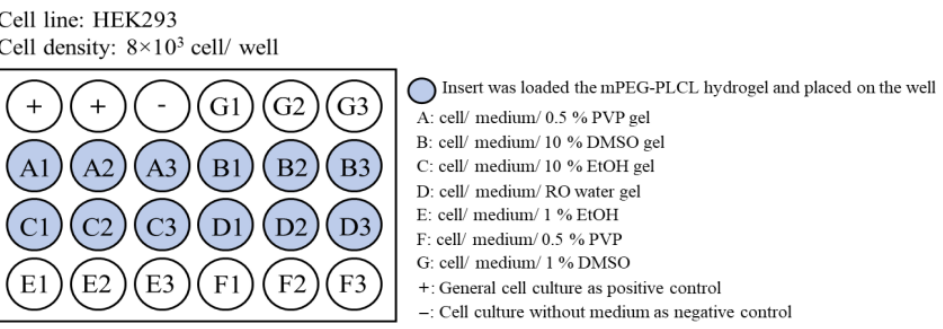
Figure 7. Biocompatibility testing of formulation of mPEG-PLCL hydrogel with different cosolvents and the effects of the cell